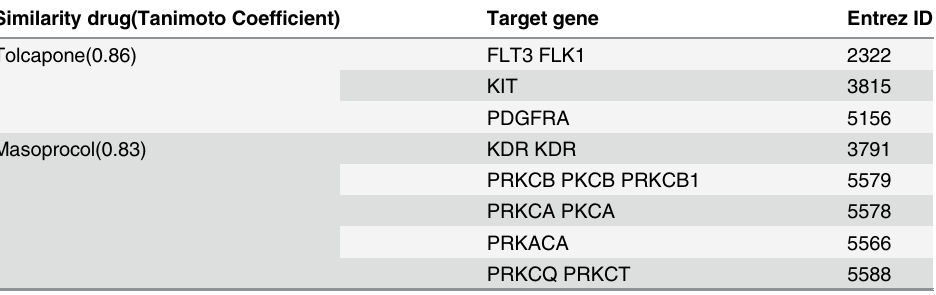
Table 2. CYNA's targets obtained from similarity search